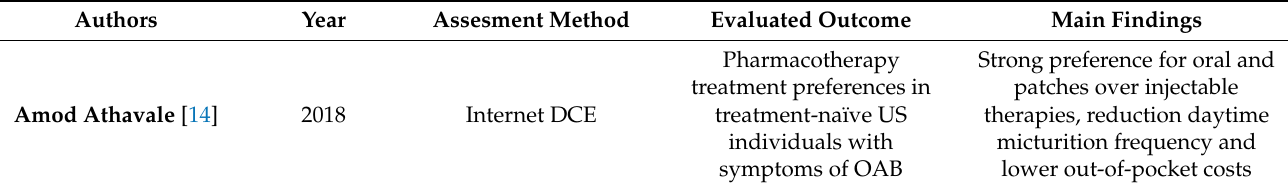
Table 1. Studies included in the systematic